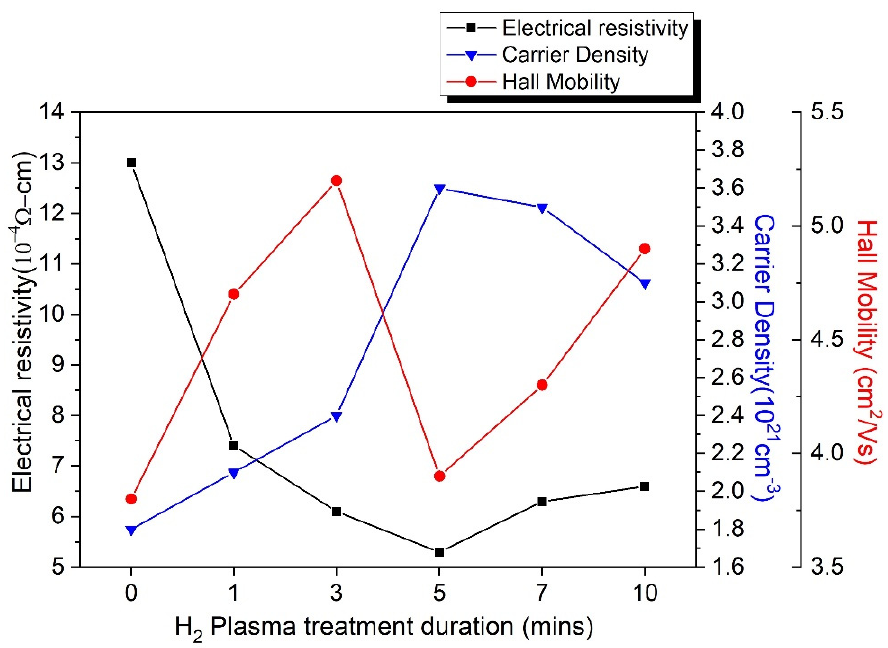
Figure 3. Electrical properties of the as-deposited and H 2 plasma-processed GAZO films.